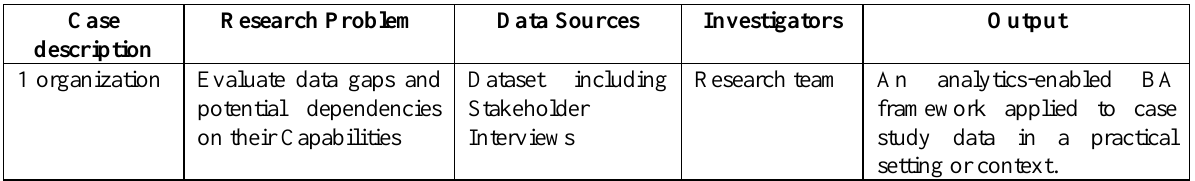
Table 5. Case study